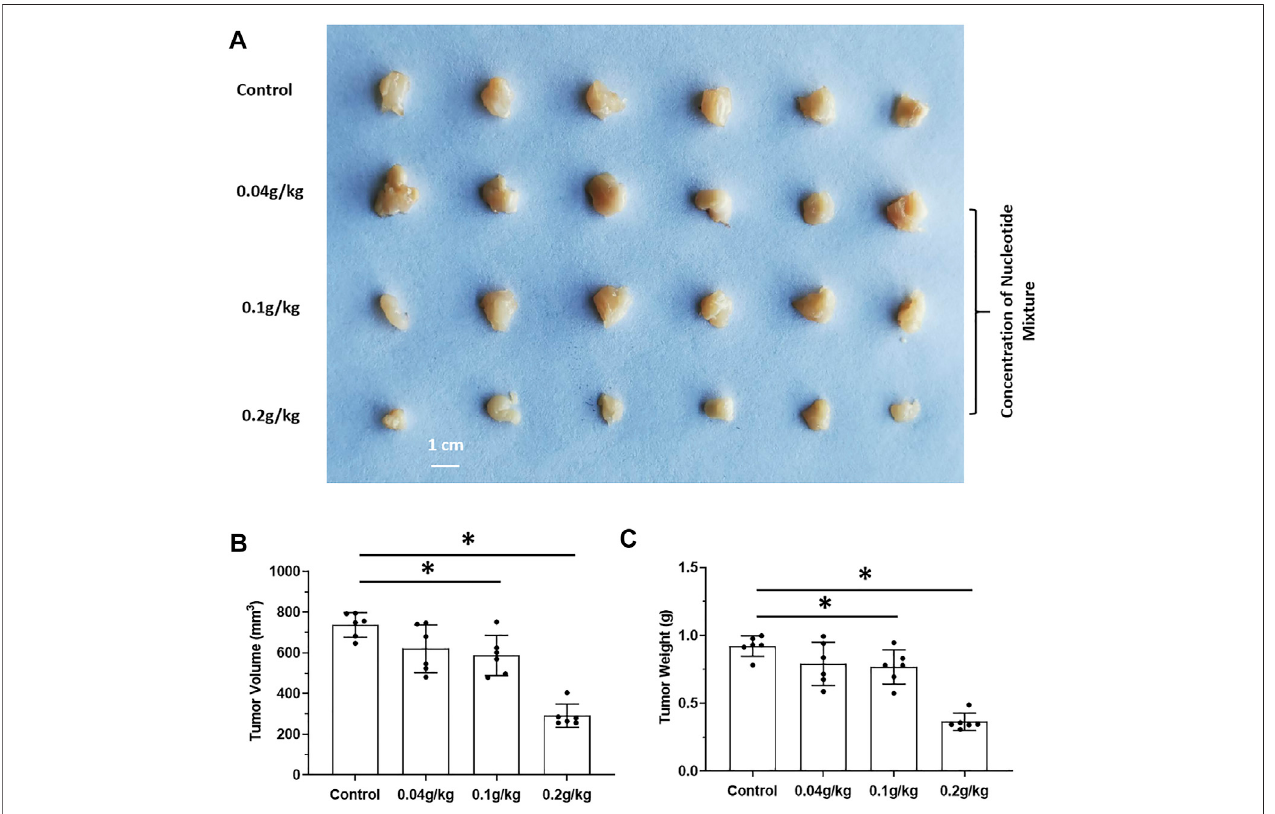
FIGURE 2 | The tumorigenic effect of nucleotide mixture alone on mouse HCC cells H22 in immunized normal mice. H22 cells were inoculated into BalB/c mice subcutaneously. Then, mice were administered (p.o.) with the SNM (0.04, 0.1, 0.2 g/kg). A photograph of a subcutaneous tumor (A) and the tumor volume (B) , tumor weights (C) are shown. * p <